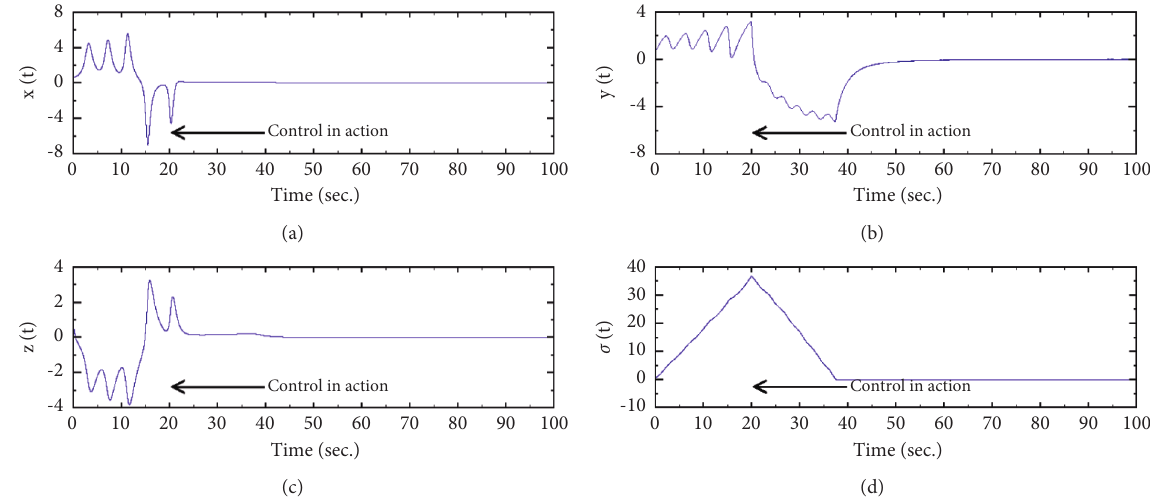
Figure 12: The time series of the controlled commensurate fractional-order system state variables and corresponding time series of the sliding surface with uncertainty and external disturbance (the control input is activated at t � 20